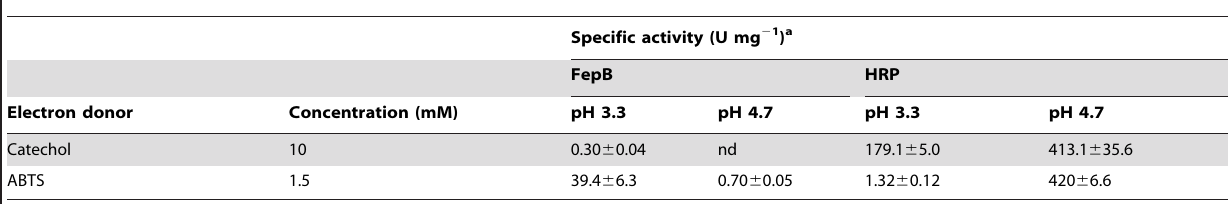
Table 2. Peroxidase